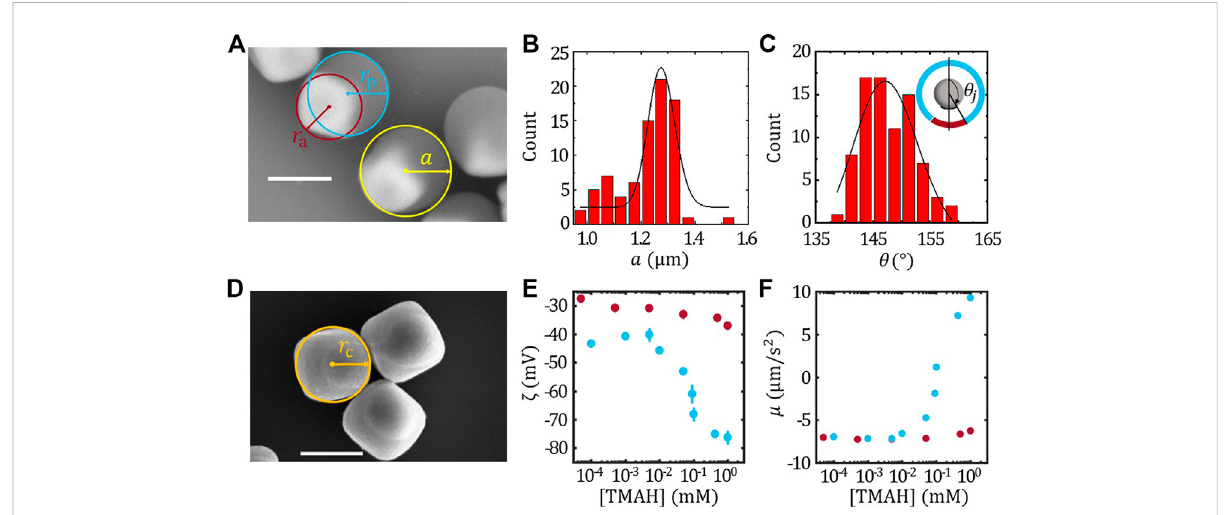
FIGURE 1 Characterization of TPM/haematite Janus colloids. (A) The SEM image of the TPM/haematite Janus colloids and the de fi nition of radius of catalytic( r a ),inert( r p )partandtheradiusoftheJanuscolloids (A) .StatisticsoftheradiusofJanuscolloids a (B) andthejoiningangle θ j (C) .Theinsetof (C) illustratesthede fi nitionof θ j . (D) SEMimageofthehaematitecolloidsandthede fi nitionoftheequivalentradiusofhaematite r c .The ζ potential (E) and the surface mobility (F) of the haematite (red) and TPM (blue) colloids. Scale bar = 1 μ